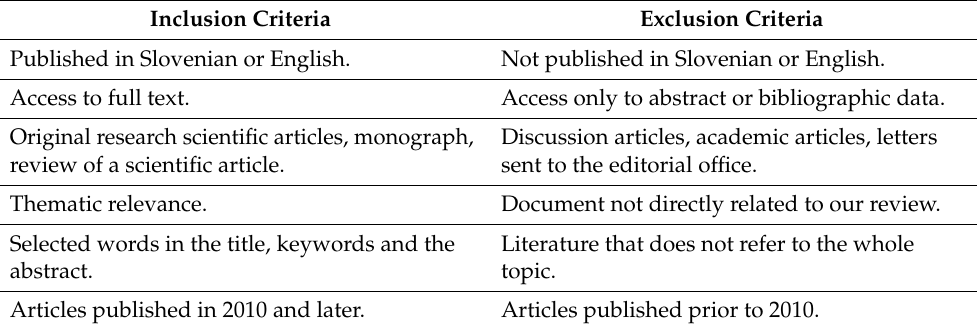
Figure 1. Adapted PRISMA diagram. PRISMA: Preferred Reporting Items for Systematic Reviews and Meta-Analyses. Table 2. Inclusion and exclusion criteria.